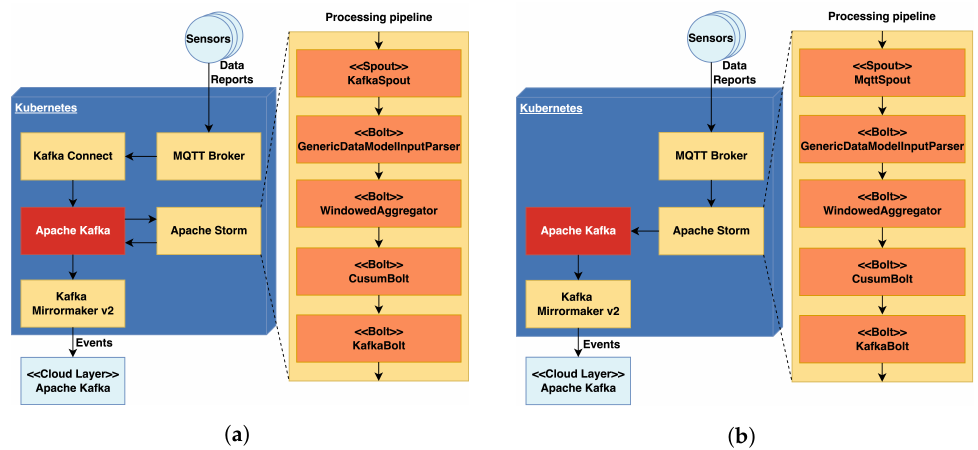
Figure 5. Implementation of the Ferrovia 4.0 architectures. ( a ) K0-WC uses Kafka Connect to integrate the MQTT source. ( b ) No Kafka Connect is used by K1-NC, instead consuming the MQTT source directly. Kubernetes implicitly uses Grafana [41] and Prometheus [42] for resource